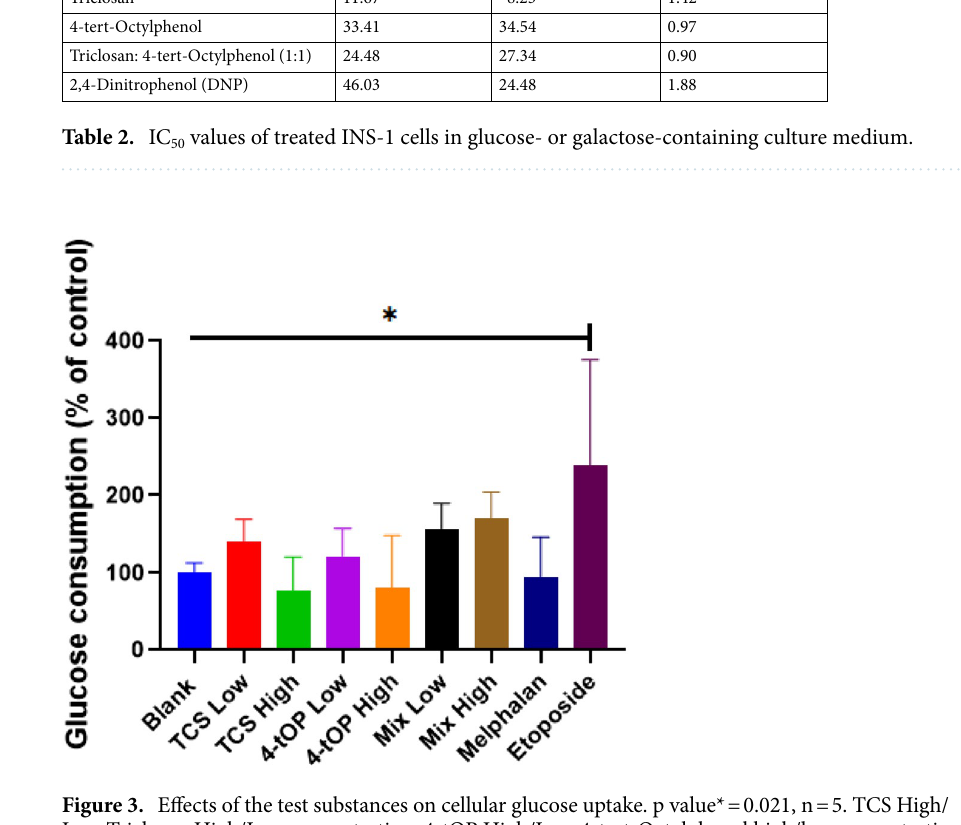
Figure 2. Differential cytotoxicity of INS-1 cells cultured in glucose or galactose medium. INS-1 cells were treated with varying concentrations of Triclosan, 4-tert-Octylphenol, 1:1 molar Triclosan: 4-tert-Octylphenol and 2, 4-Dinitrophenol (DNP). Compound